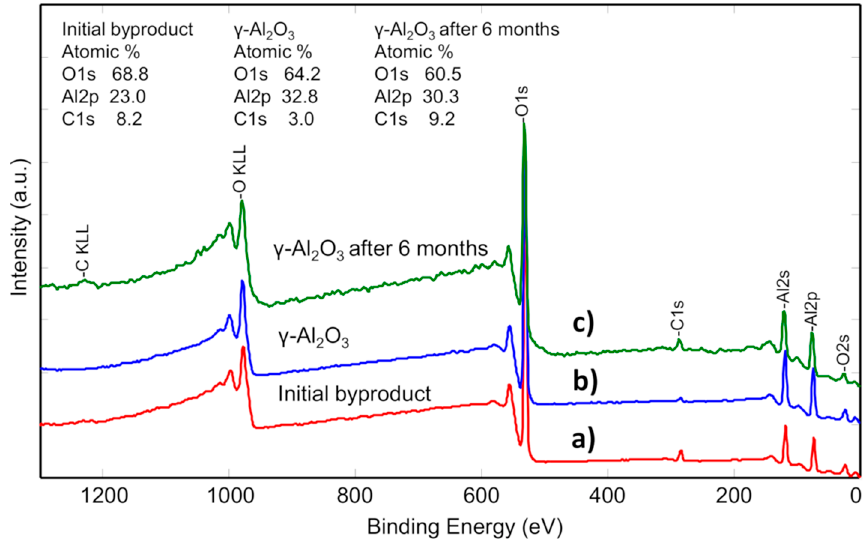
Figure 5. Results of XPS elemental composition: ( a ) byproduct after aluminum/water reaction, ( b ) the gamma alumina after heat-treatment at 500 °C for 20 h and ( c ) gamma Al 2 O 3 stored for 6 months under the atmospheric conditions.